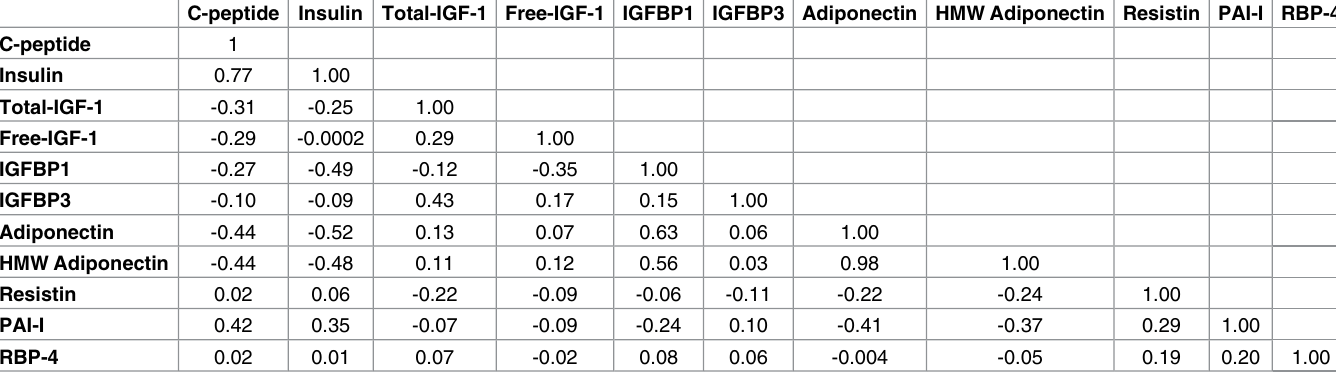
Table 2. Spearman’scorrelation matrix for the insulin/IGF-1 axis parameters and adipokines measuredon blood samples collected 1 hour after the researchbreakfast